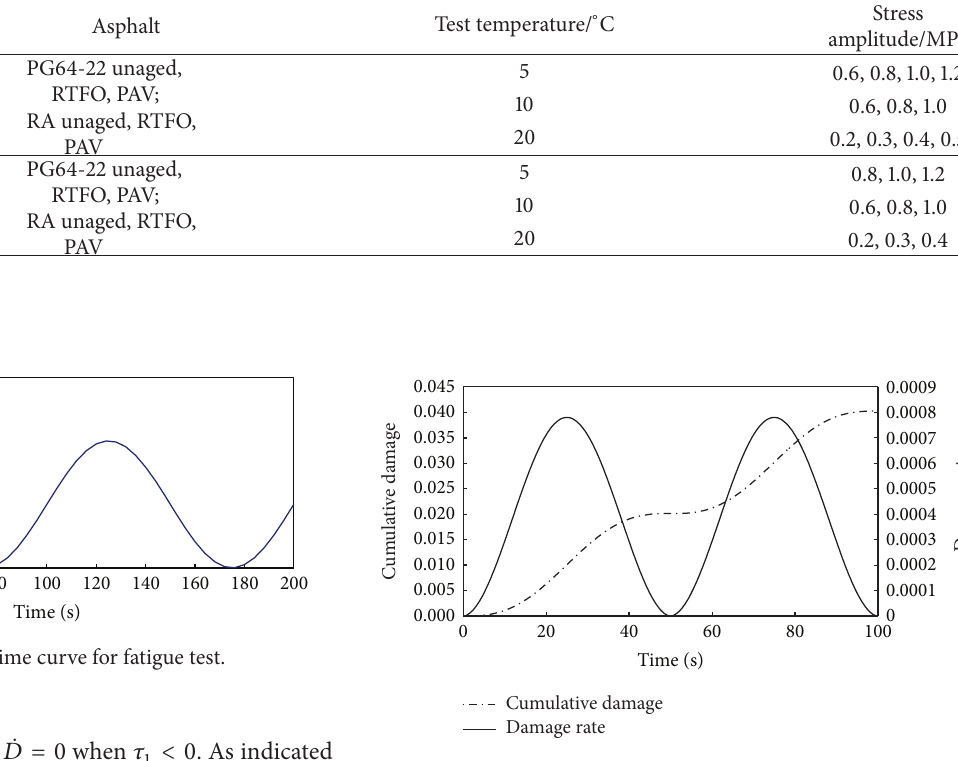
Figure 4. The same stress amplitude was supposed to